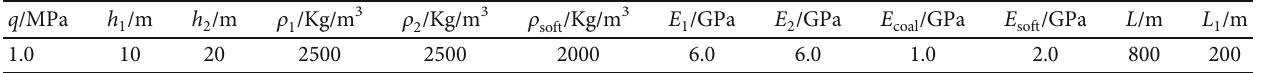
Table 1: The calculation parameters.